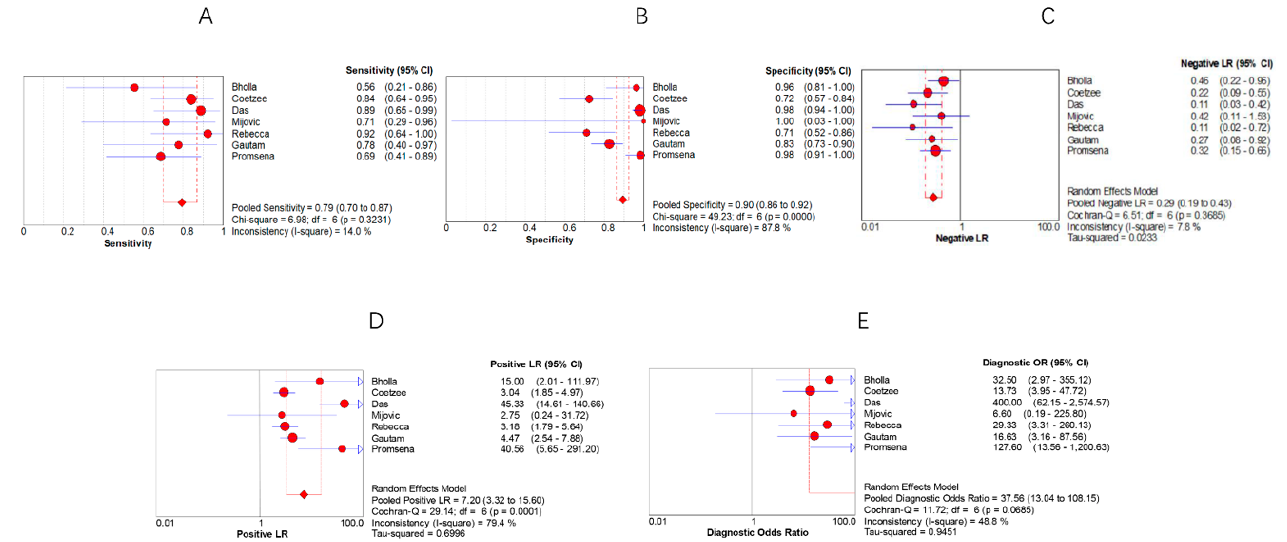
Figure 3. Forest plots of ( A ) sensitivity, ( B ) specificity, ( C ) negative likelihood ratio, ( D ) positive likelihood ratio, and ( E ) diagnostic odds ratio of Xpert for the diagnosis of LNTB in children.